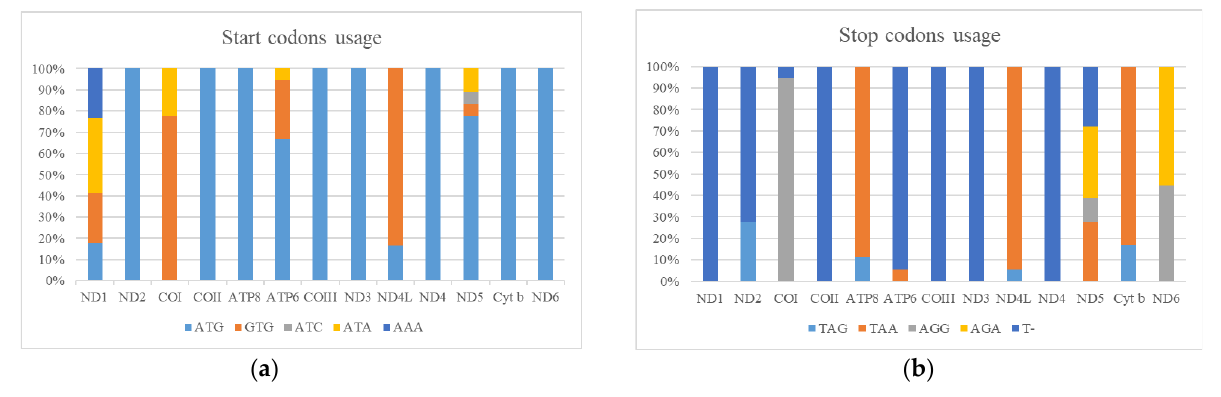
Figure 3. The usage of start ( a ) and stop ( b ) codons in the 13 mitochondrial protein-coding genes of Rana . Table 3. Variation analysis and base composition of 13 PCG genes in Rana .